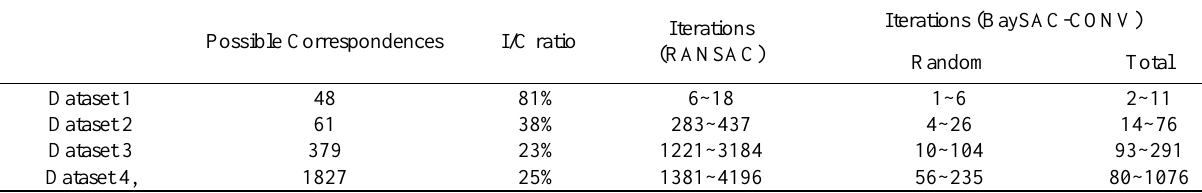
Table 6. Computational efficiencies of the proposed strategies.